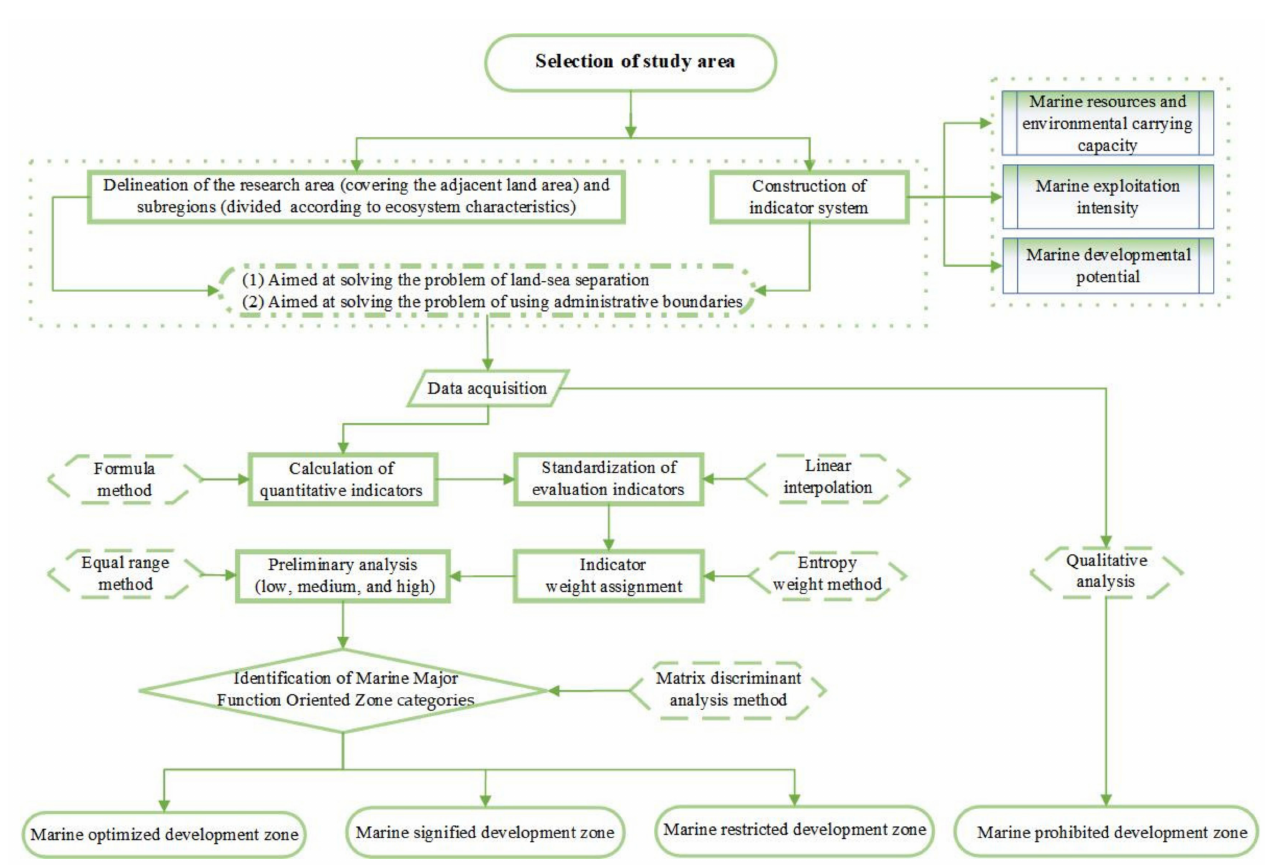
Figure 2. Conceptual framework of the research